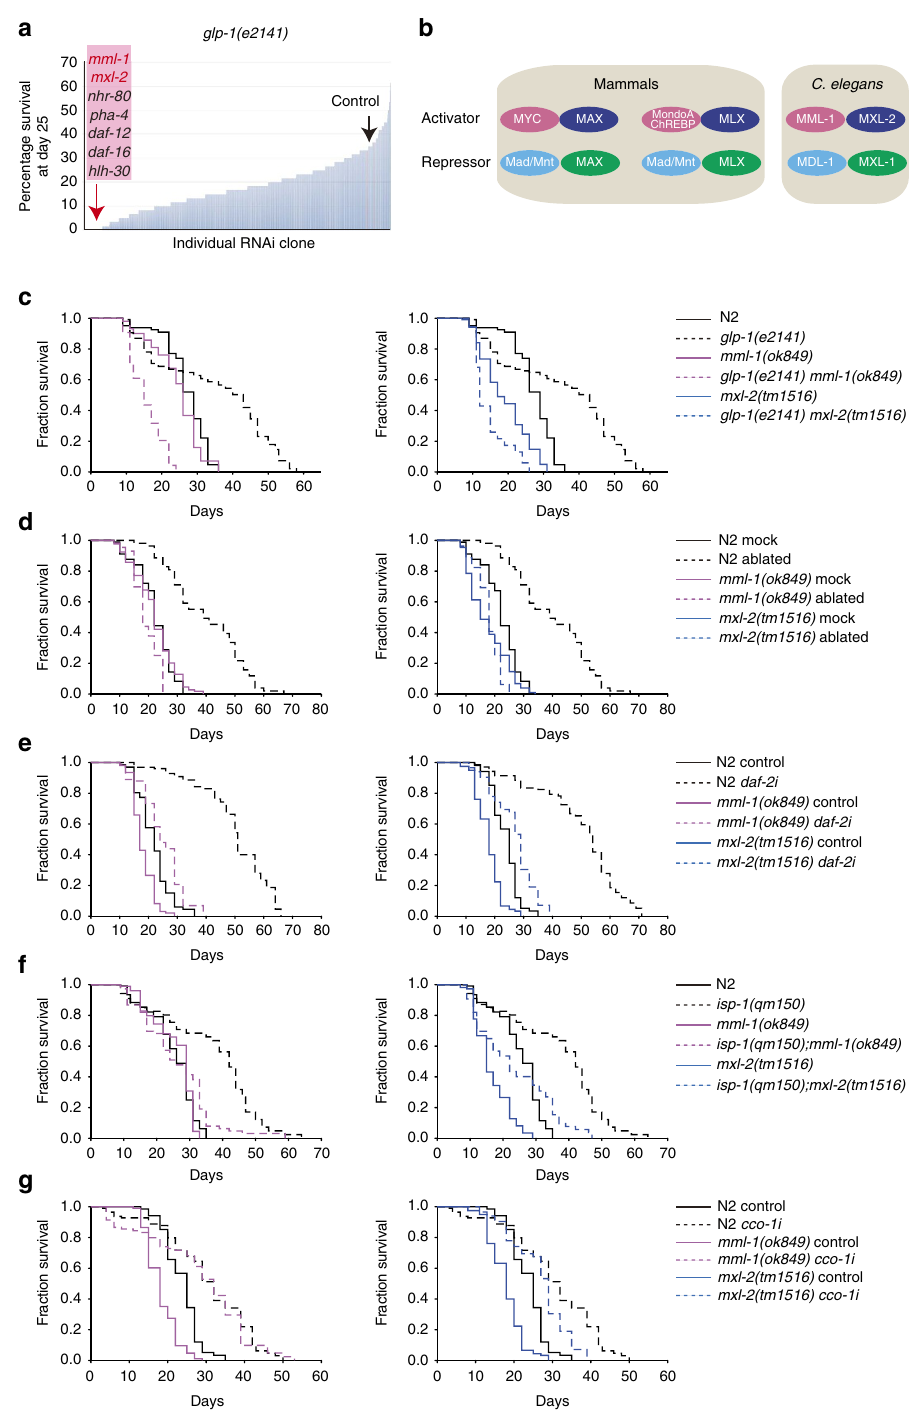
Figure 1 | MML-1/MXL-2 are required for multiple longevity pathways. ( a ) glp-1(e2141) suppressor screens identify mml-1 and mxl-2 as new transcription factors required for gonadal longevity. Survivorship of glp-1(e2141) worms on control RNAi (L4440, black arrow) and experimental RNAi was determined at day 25. Knockdown of known factors (for example, daf-16 , daf-12 and hlh-30 ), as well as mml-1 and mxl-2 , completely suppressed glp-1 survivorship. Survivorship of 60 worms was determined and screening conducted twice. ( b ) C. elegans Myc superfamily comprises MML-1/MXL-2 and MDL-1/MXL-1 complexes. ( c–g ) Roles of mml-1 and mxl-2 in various longevity pathways. mml-1(ok849) and mxl-2(tm1516) deletions suppress longevity of germline-deficient glp-1(e2141) mutants ( c ) and animals with germline laser microsurgery ( d ). mml-1 and mxl-2 suppress longevity of daf-2 RNAi ( e ). mml-1 is required for isp-1 (qm150) longevity (f) but not required for the longevity conferred by cco-1 RNAi ( g ). mxl-2 is not specifically required for isp-1 or cco-1 RNAi longevity ( f , g ). See Supplementary Table 1 for details and mml-1/mxl-2 regulates autophagy . Autophagy is an essential in germline-deficient animals 19,28,29 , we wondered whether cellular process critical to multiple longevity pathways, including MML-1/MXL-2 also affect autophagy. On autophagy induction, gonadal longevity 14,16,17,18,20 . As HLH-30 regulates autophagy foci containing the LC3 homologues LGG-1 and LGG-2 become